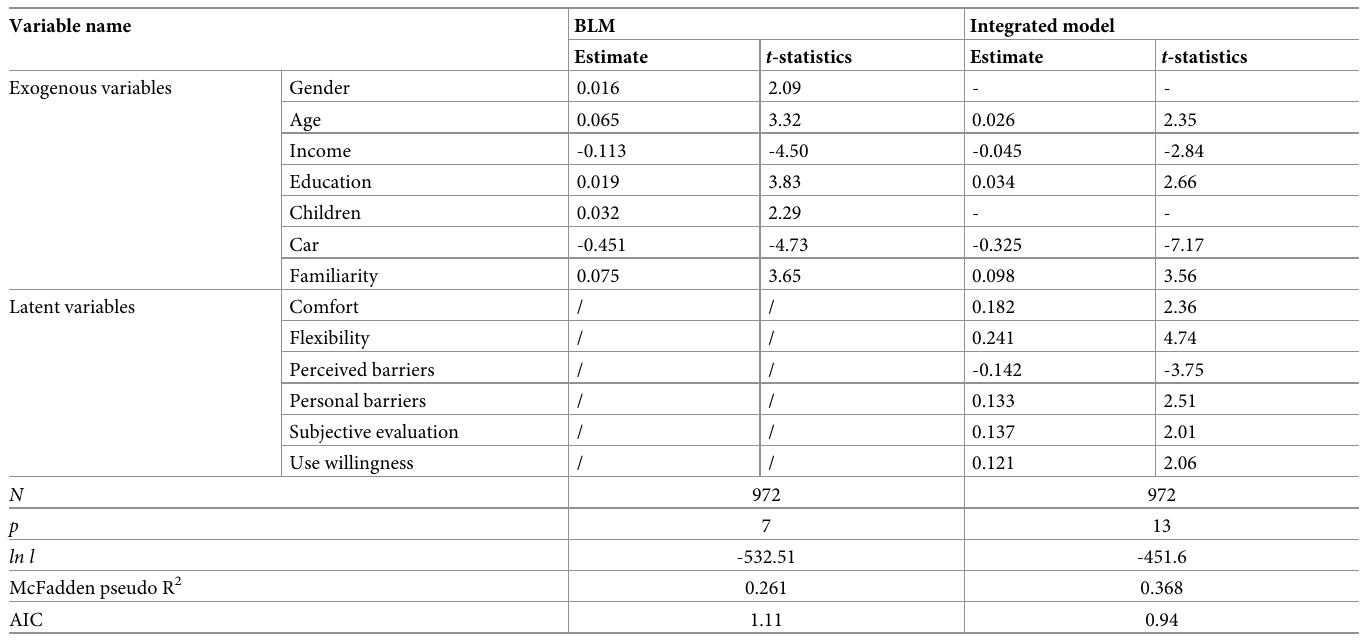
Table 5. The evaluation results of BLM and integrated model. Variable